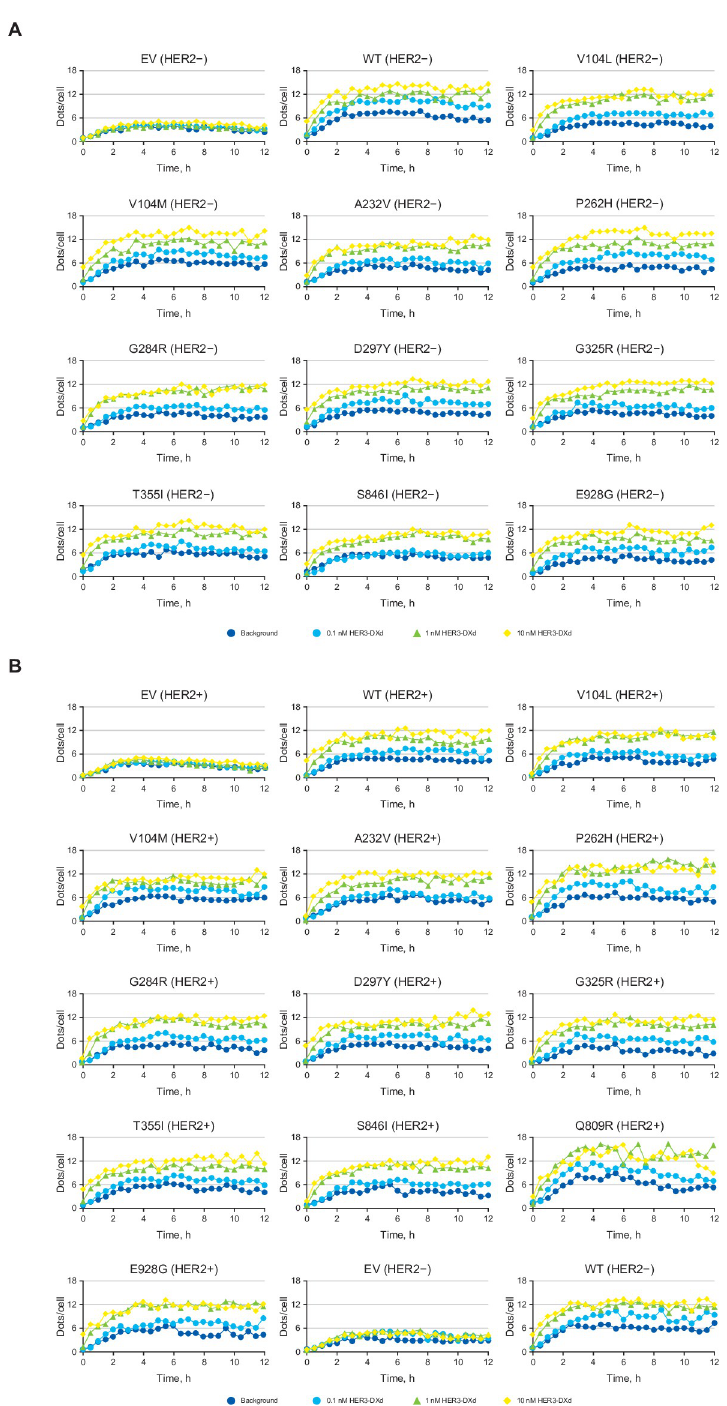
Fig 2. Trafficking (dots per cell) of pHrodo-labeled HER3-DXd in MDA-MB-231 cells transduced with HER3 WT , HER3 mutations, or HER3 EV in the absence (A) or presence (B) of HER2 overexpression. The lysosomal trafficking of 0.1, 1, and 10 nM HER3-DXd into the HER3 transfectants was determined using HER3-DXd labeled with pHrodo. Fluorescence emission images were then collected at 30-minute intervals for up to 12 hours. The level of lysosomal trafficking was expressed as the number of dots per cell. Abbreviations: EV = empty vector, HER = human epidermal growth factor receptor, WT = wild type.